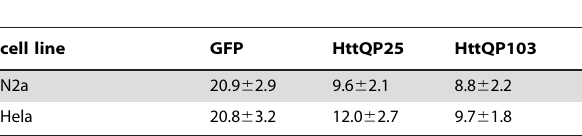
Table 1. Diffusion coefficients measured in different cell lines. *